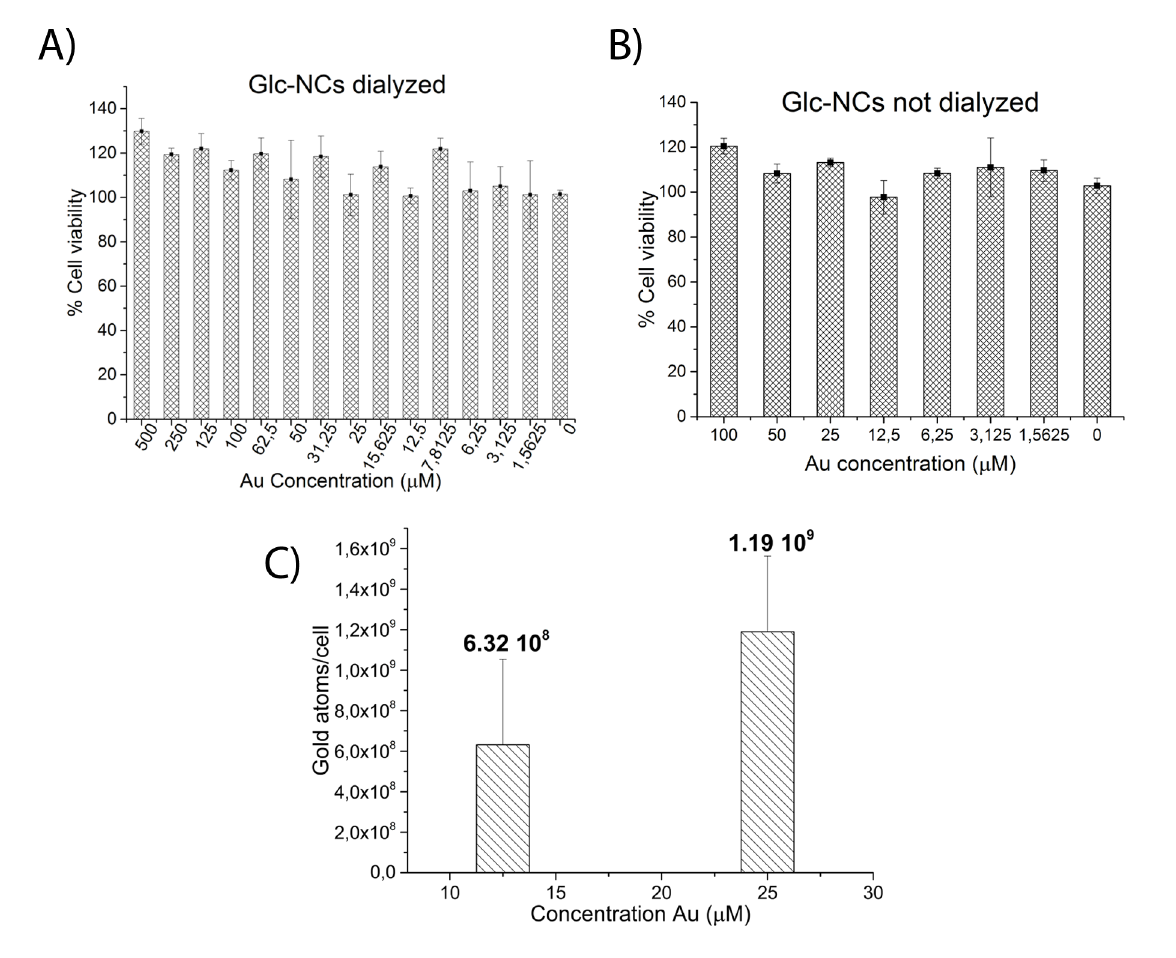
Figure 3: Cell viability of Glc-NCs A) purified and B) without purification incubated for one day with L929 cells. The Glc-NCs were not toxic at any of the concentrations studied. C) Cellular uptake of Glc-NCs when incubated with L929 cells for one day. Gold concentration taken up by the cells was measured with ICP-OES and showed an uptake of 10 8 –10 9 gold atoms per